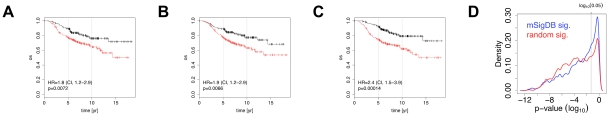
Association of negative control signatures with overall survival.In plots A–C the NKI cohort was split into two groups using a signature of post-prandial laughter (panel A), localization of skin fibroblasts (panel B), social defeat in mice (panel C). In panels A–C, the fraction of patients alive (overall survival, OS) is shown as a function of time for both groups. Hazard ratios (HR) between groups and their associated p-values are given in bottom-left corners. Panel D depicts p-values for association with outcome for all MSigDB c2 signatures and random signatures of identical size as MSigDB c2 signatures.